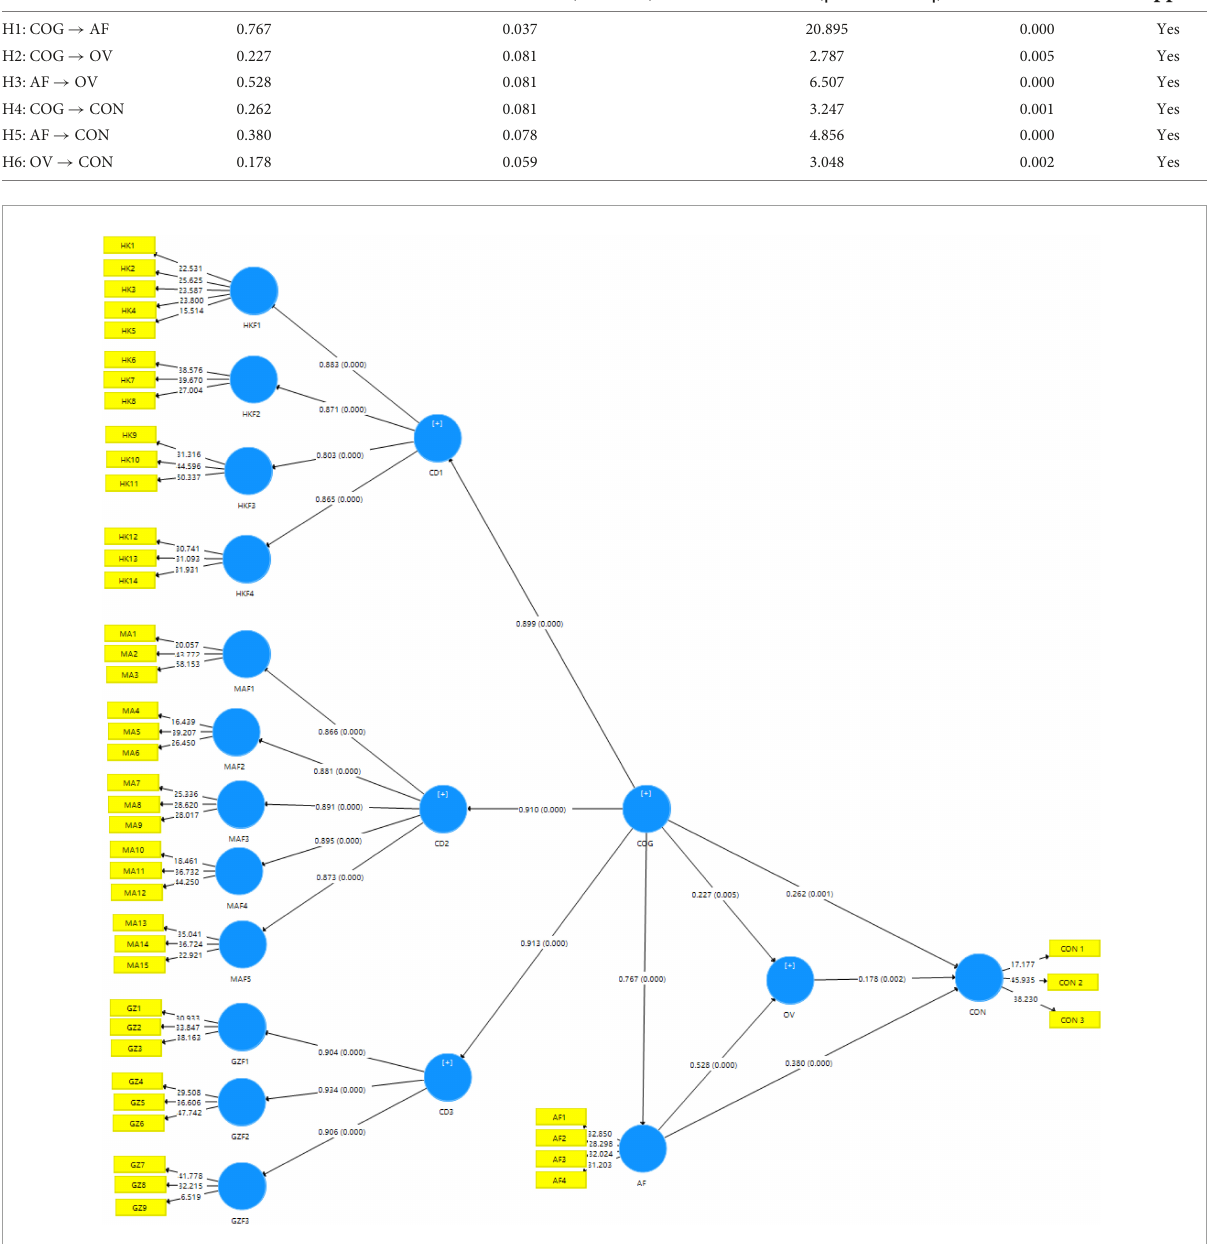
FIGURE3 Results of PLS-SEM analysis of